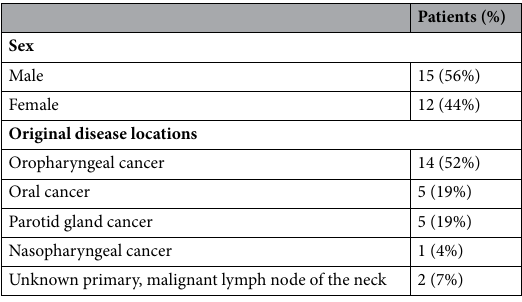
Table 1. Patient